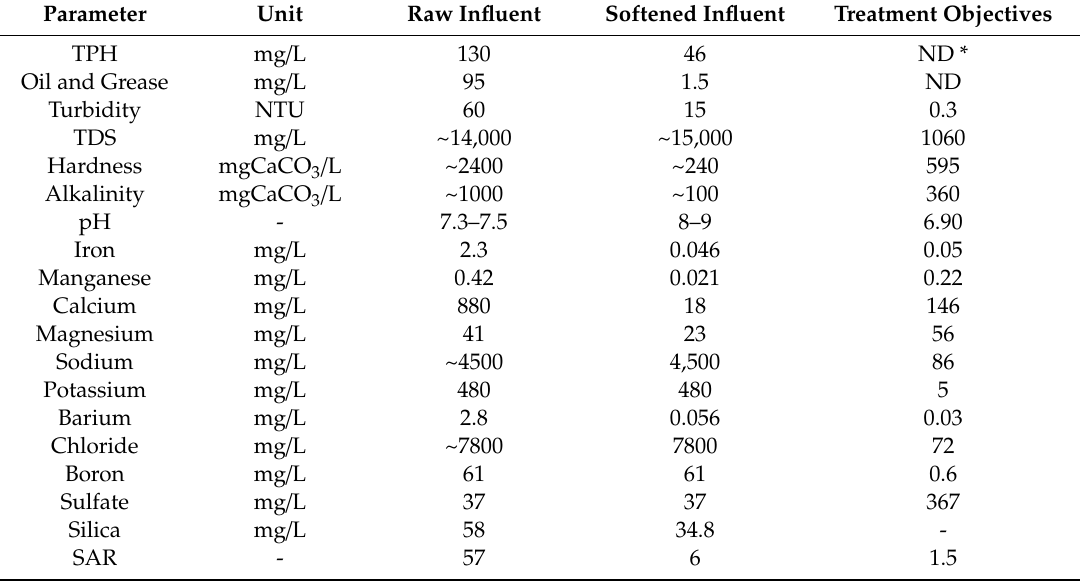
Table 5. Key produced water quality and treatment objectives for this project. Parameter Unit Raw Influent Softened